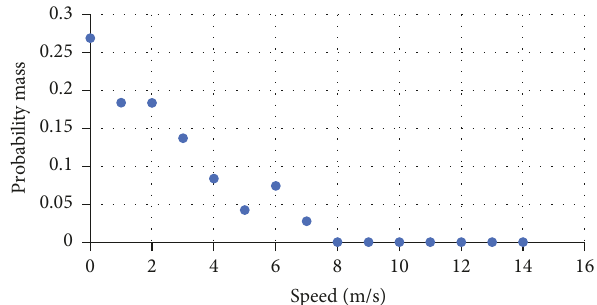
Figure 7: Average pmf for the speed at the street crossings.